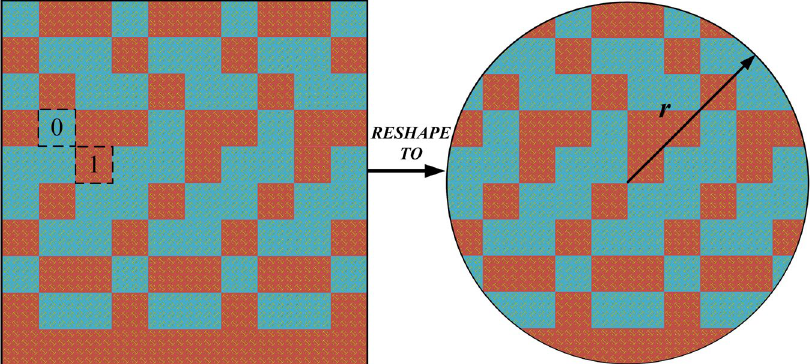
Figure 9. Reshaping of the 1-bit random coding metasurface from a rectangular to circular shape.